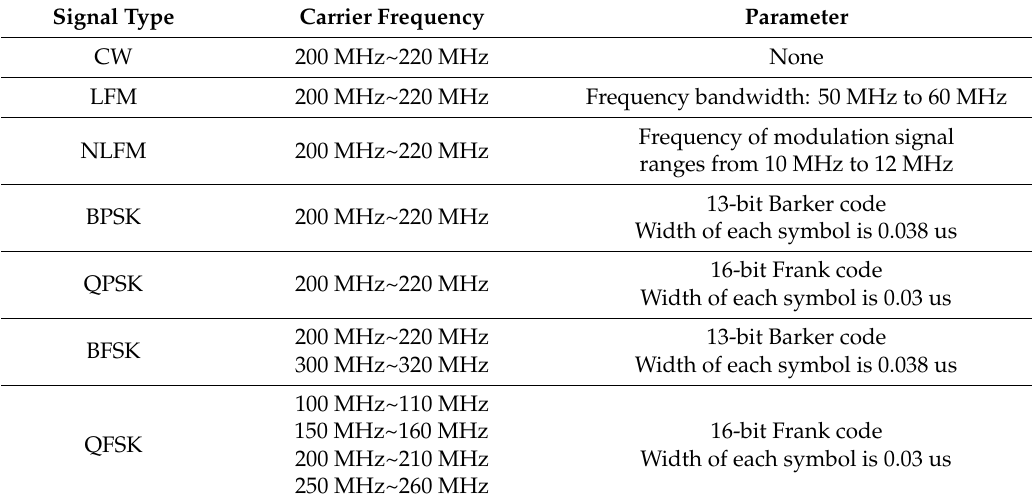
Table 2. Specific parameters of seven types of radar emitter